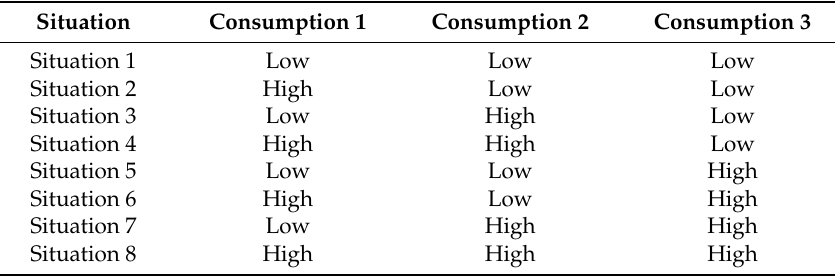
Table 4. Power consumption trend